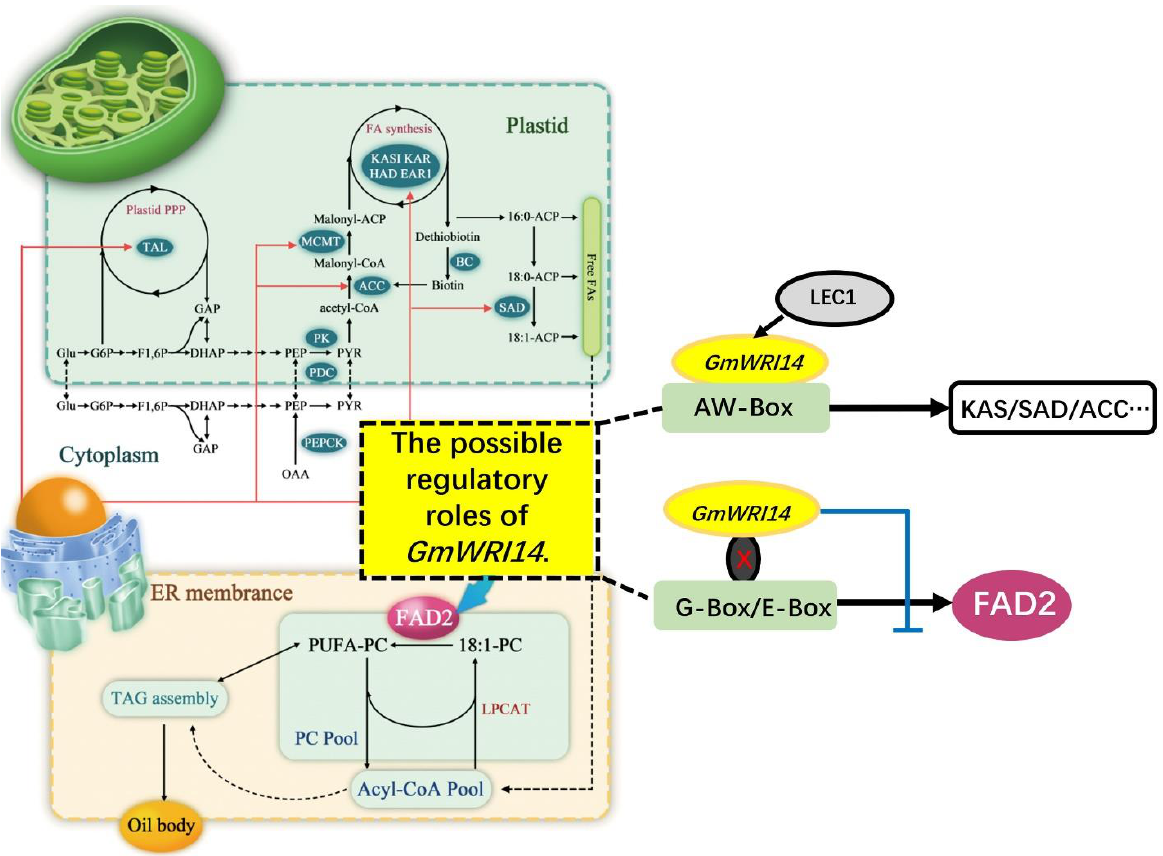
Figure 4. The model depicting transcriptional control by GmWRI14 . Red arrow lines represent the possible regulatory roles of GmWRI14 . Blue bar: GmWRI14 suppresses the expression of FAD2 gene by cooperating with the trans-acting factor (depicted as “X”). Abbreviations: PEPCK, phosphoenolpyruvate carboxykinase; SAD, stearoyl-ACP desaturase; BS, biotin synthase; KAS, ketoacyl-ACP synthase; EAR1, enoyl-ACP reductase 1; KAR, ketoacyl-ACP reductase; MCMT, malonyl-CoA; BC, biotin carboxylase; TAL, transaldolase; FAD2, fatty acid desaturase 2. Black arrow in G-Box/E-Box: G-Box/E-Box elements regulate FAD2 gene transcription; blue bar in G-Box/E-Box: GmWRI14 suppresses the expression of FAD2 genes by interfering with E-Box/G-Box-mediated transcription.